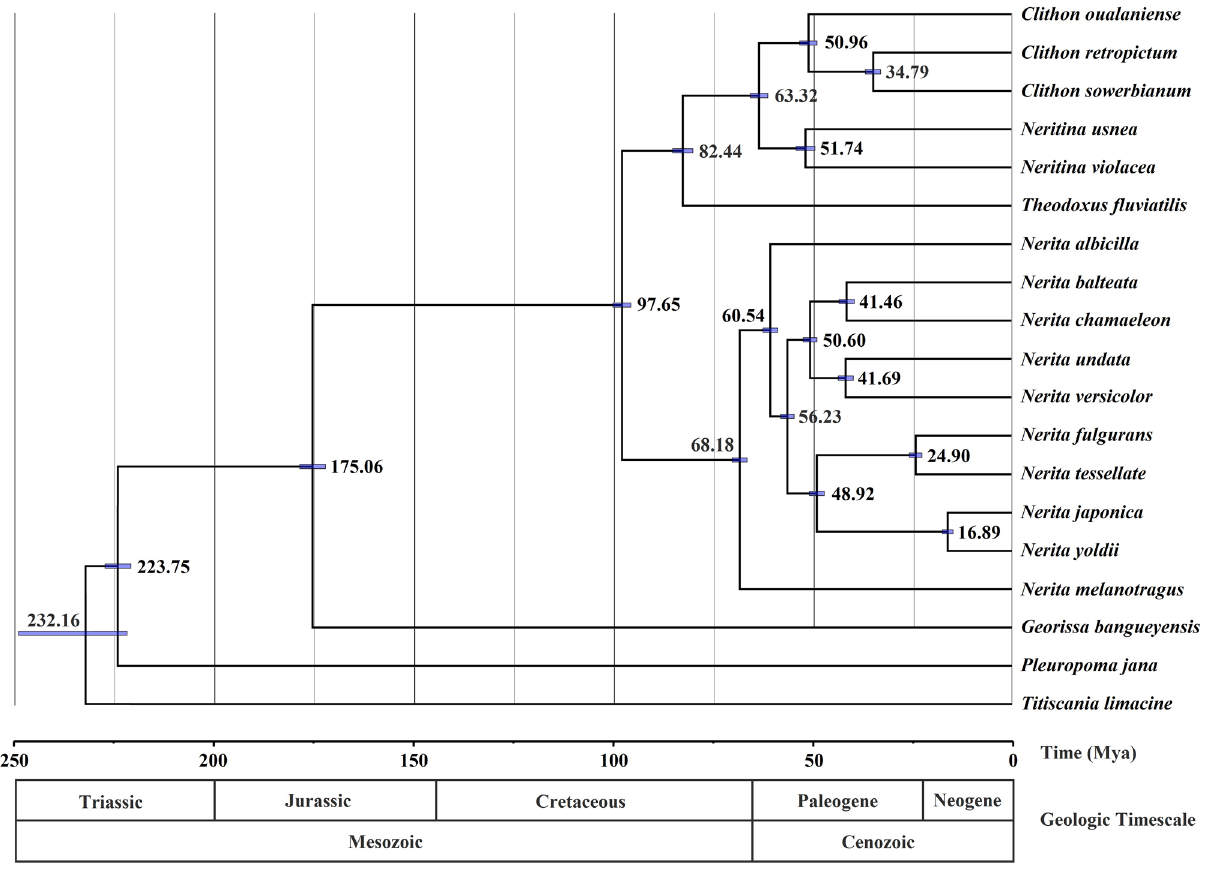
Figure 7. Divergence time estimation for Neritimorpha inferred via Bayesian relaxed dating methods (BEAST) based on the nucleotide sequences of 12 PCGs (excluding the cox3 gene). Fossil samples used to calibrate internal nodes are indicated by an asterisk. The 95% HPD is reported as blue bars, and Bayesian posterior probabilities are reported for each node. The accession numbers of the sequences used in the time-calibrated tree analysis are listed in Supplementary Table